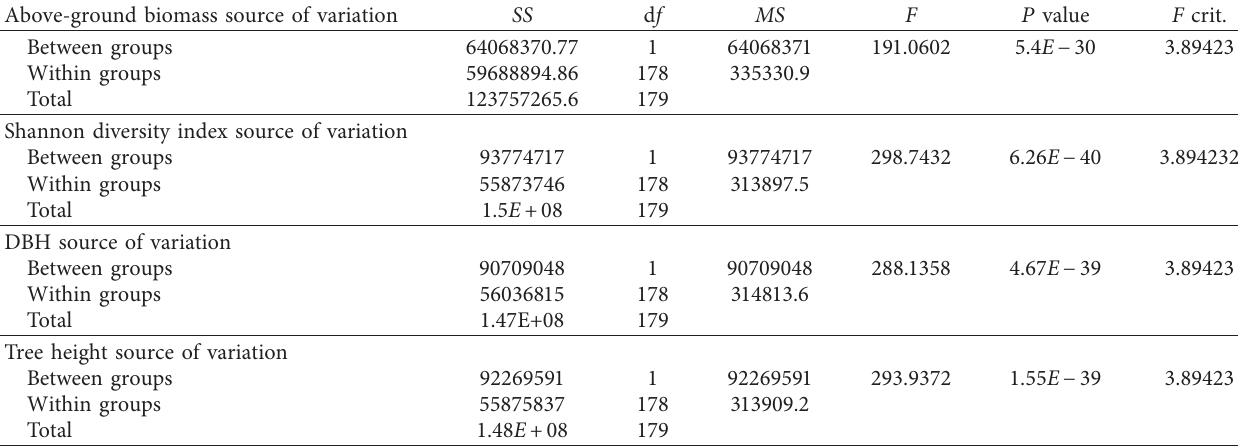
Table 2: Analysis of variance (ANOVA) of elevation with respect to different